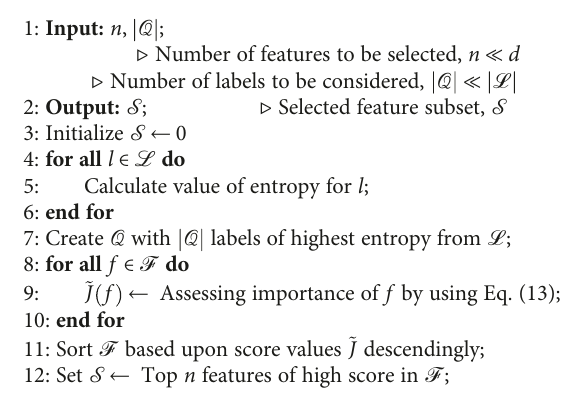
Algorithm 1: Procedure of Proposed